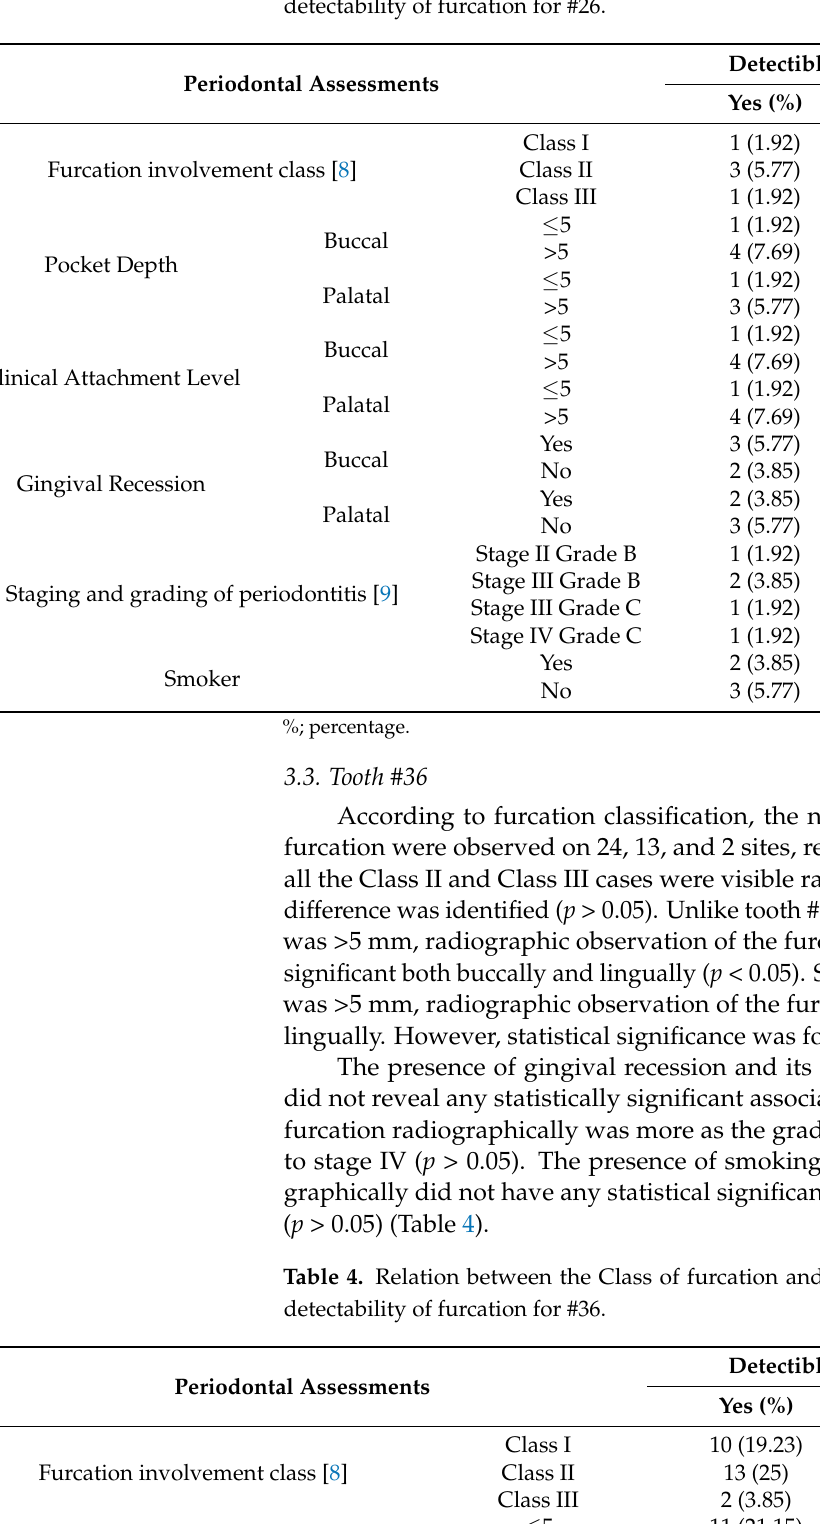
Table 3. Relation between the Class of furcation and other periodontal data to the radiographic detectability of furcation for #26.